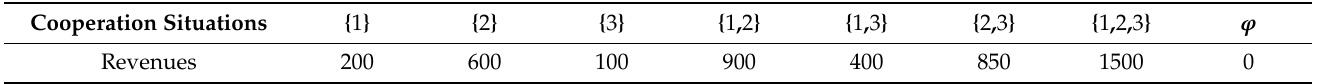
Table 1. Revenue parameter values of logistics enterprises under different cooperation situations.